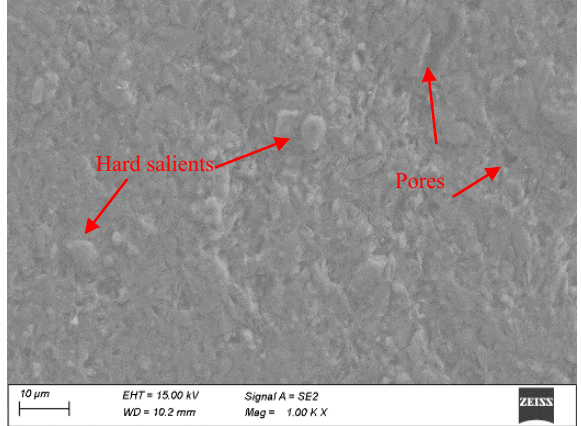
Figure 7. SEM image of shale showing hard salients and pores.